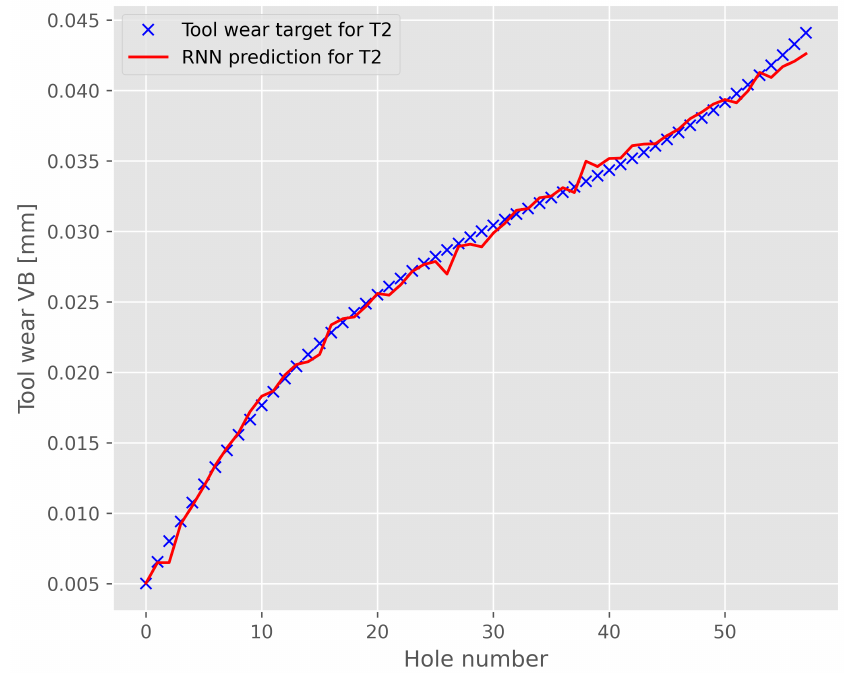
Figure 11. Comparison between RNN prediction for architecture (41, 21) with memory window w = 2 and experimental tool wear target for experiment 2, with process parameters reported in Table 1.